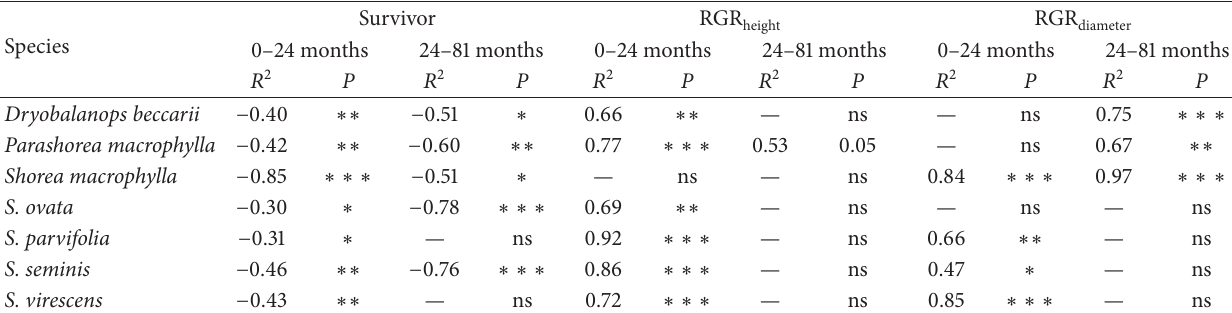
) and diameter height